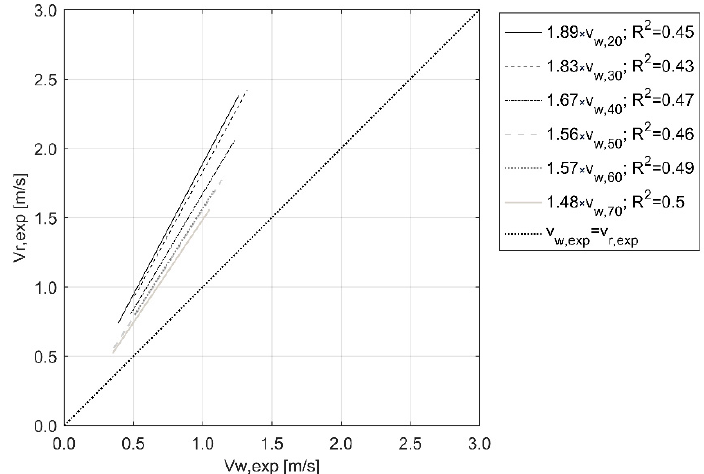
Figure 4. Database characterization depending on v w,exp and v r,exp pairs, for each individual, by distinguishing the linear regressions for each of the tested D . The regression equations are shown as a function of the respective v w,exp for the considered D value (subscript expressed in (cm)).